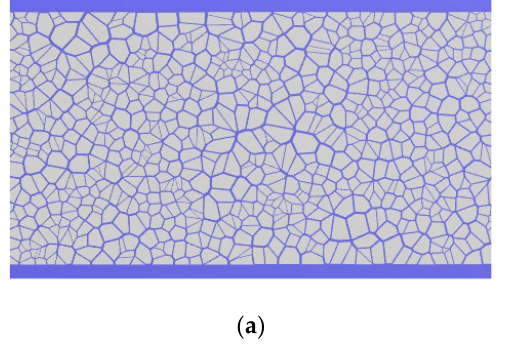
Figure 4. Schematic diagram of broken ice floes area under different conditions: ( a ) 80% ice concen- tration, the average area of 20 m 2 of ice floes condition; ( b ) 80% ice concentration, the average area of 100 m 2 of ice floes condition.